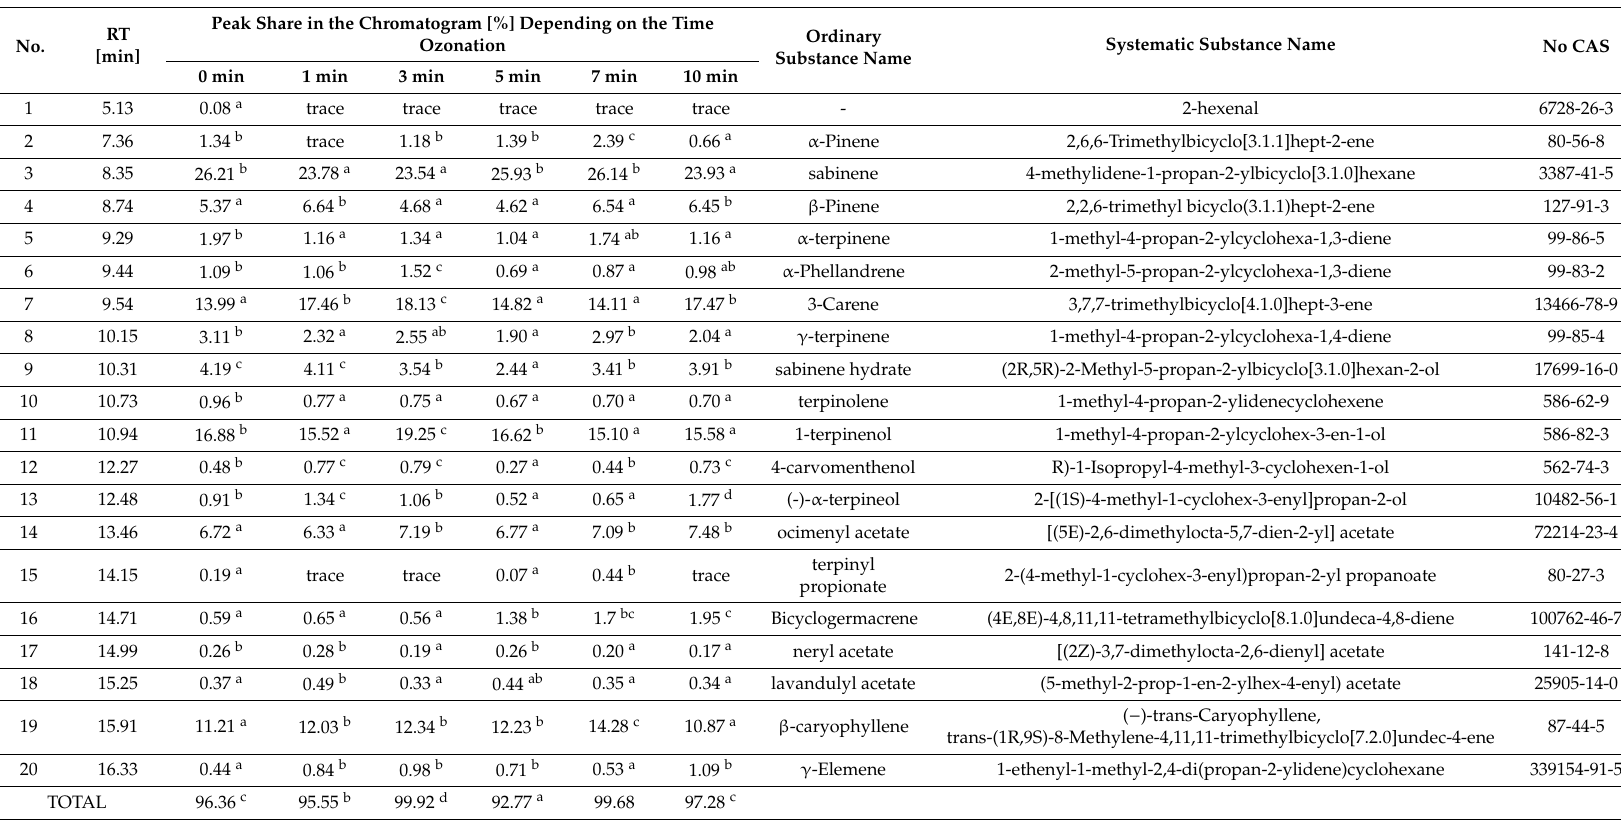
Table 2. Chemical composition of headspace fractions of leaves of Origanum majorana L. leaves depending on the time ozonation in five day from ozonation (n = 3).